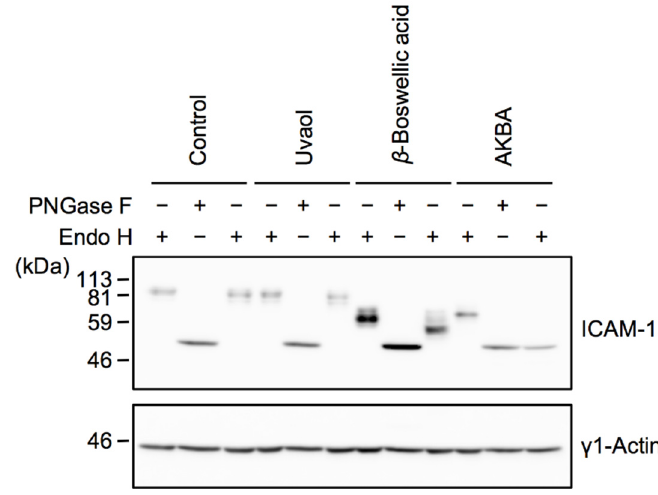
Figure 6. Effects of ursane-type pentacyclic triterpenoids on the Endo H sensitivity of ICAM-1 N -glycans. A549 cells were preincubated with triterpenoids for 1 h, and then incubated with IL-1 α (0.25 ng/mL) for 6 h in the presence of uvaol (100 µM), β -boswellic acid (100 µM) or AKBA (50 µM). Cell lysates were treated with (+) or without ( − ) PNGase F or Endo H and then analyzed by Western blotting. Blots are representative of three independent experiments.